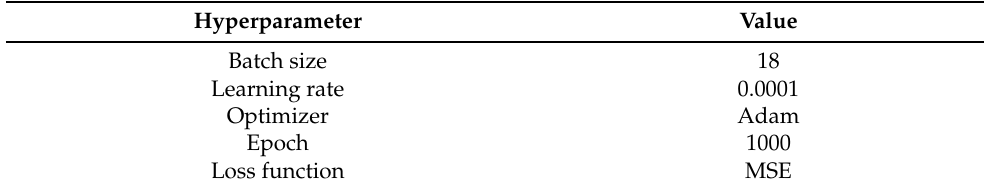
Table 3. Hyperparameters of the model optimization.